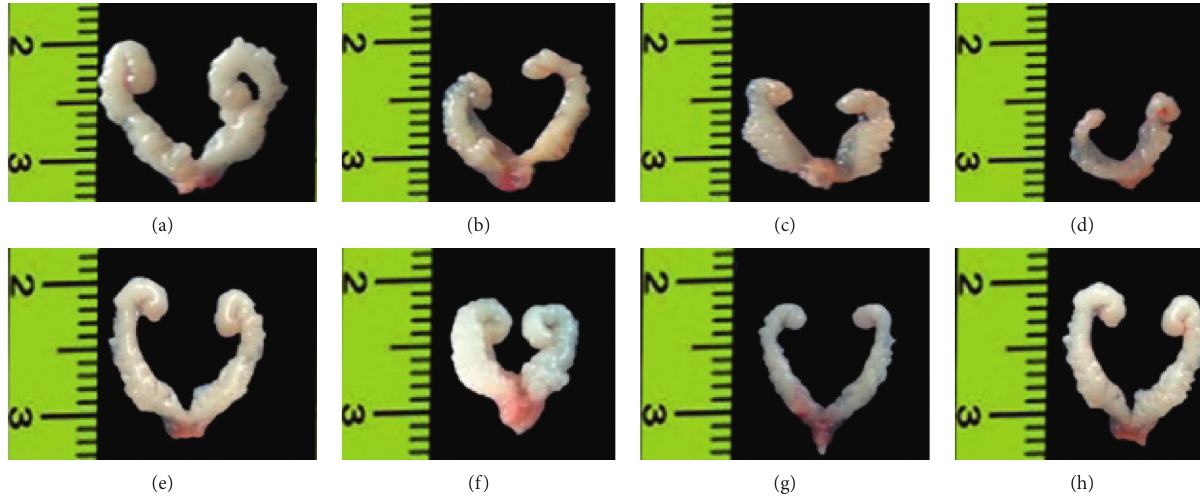
Figure 4: Seminal vesicle of mice exposed to prenatal baicalein (BC) without or with testosterone (T) injection. (a) and (e) Control. (b), (c), and (d) 30, 60, and 90mg · BC/kg body weight (BW) exposed F1 males, respectively; (f), (g), and (h) 30, 60, and 90mg BC/kg BW exposed F1 males administered with 4.16mg T/kg BW,